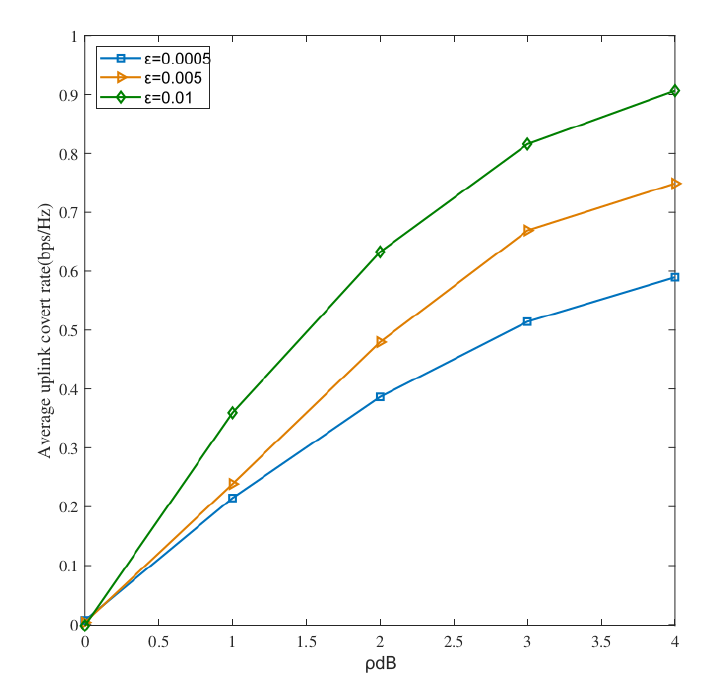
Figure 6. The average uplink covert rate under different noise